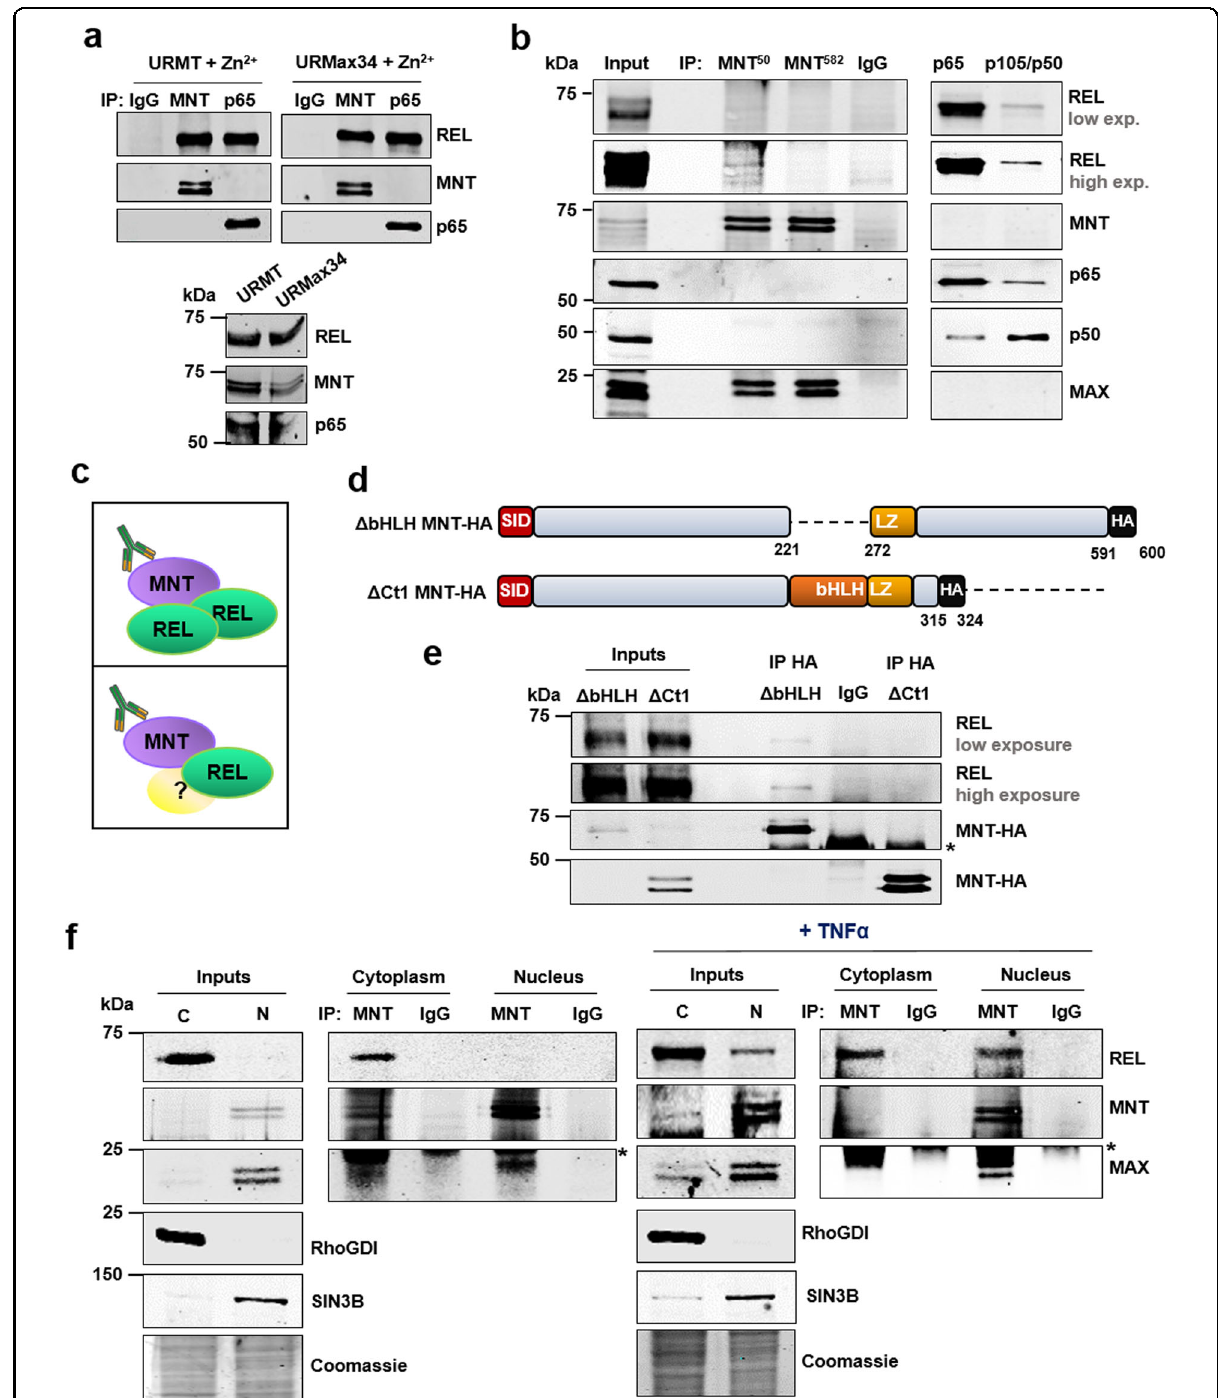
Fig. 3 (See legend on next